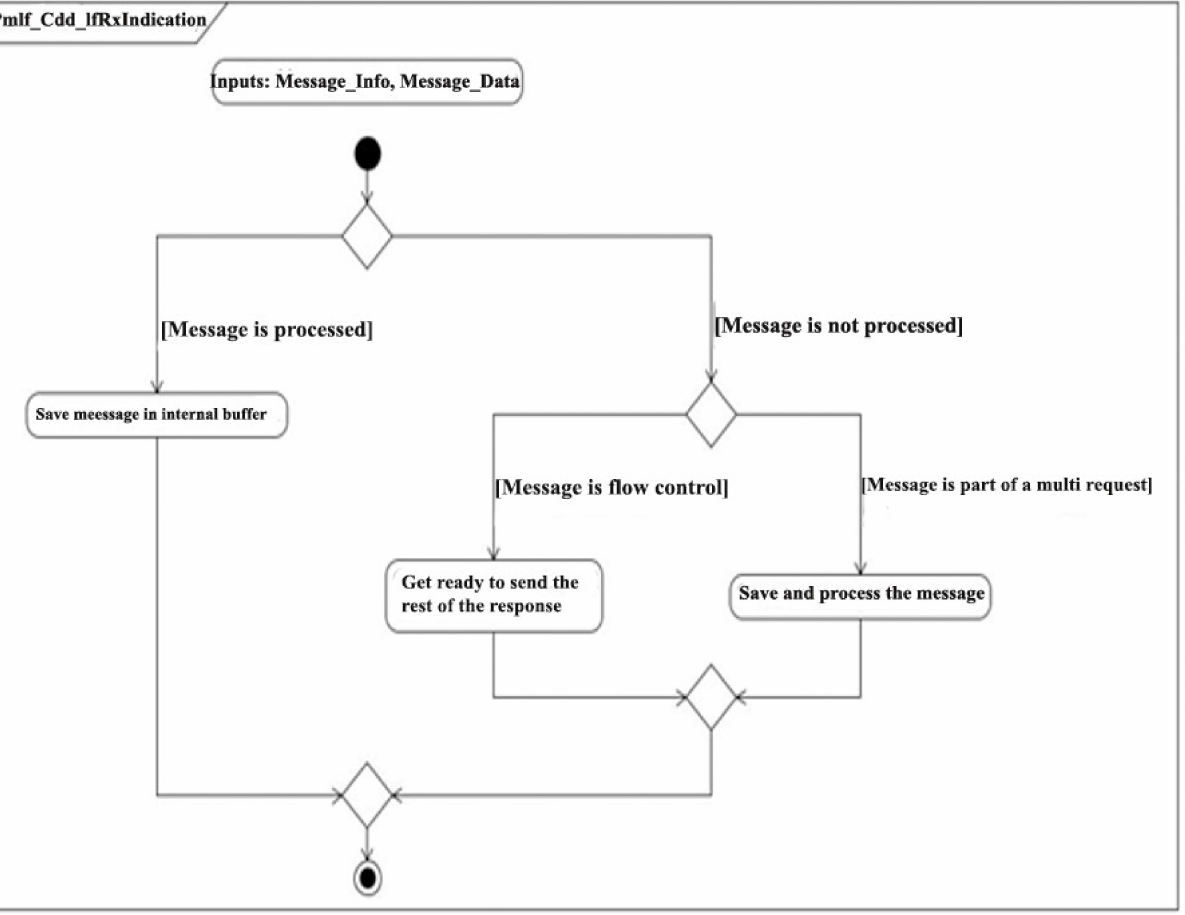
Figure 15. Rx Indication